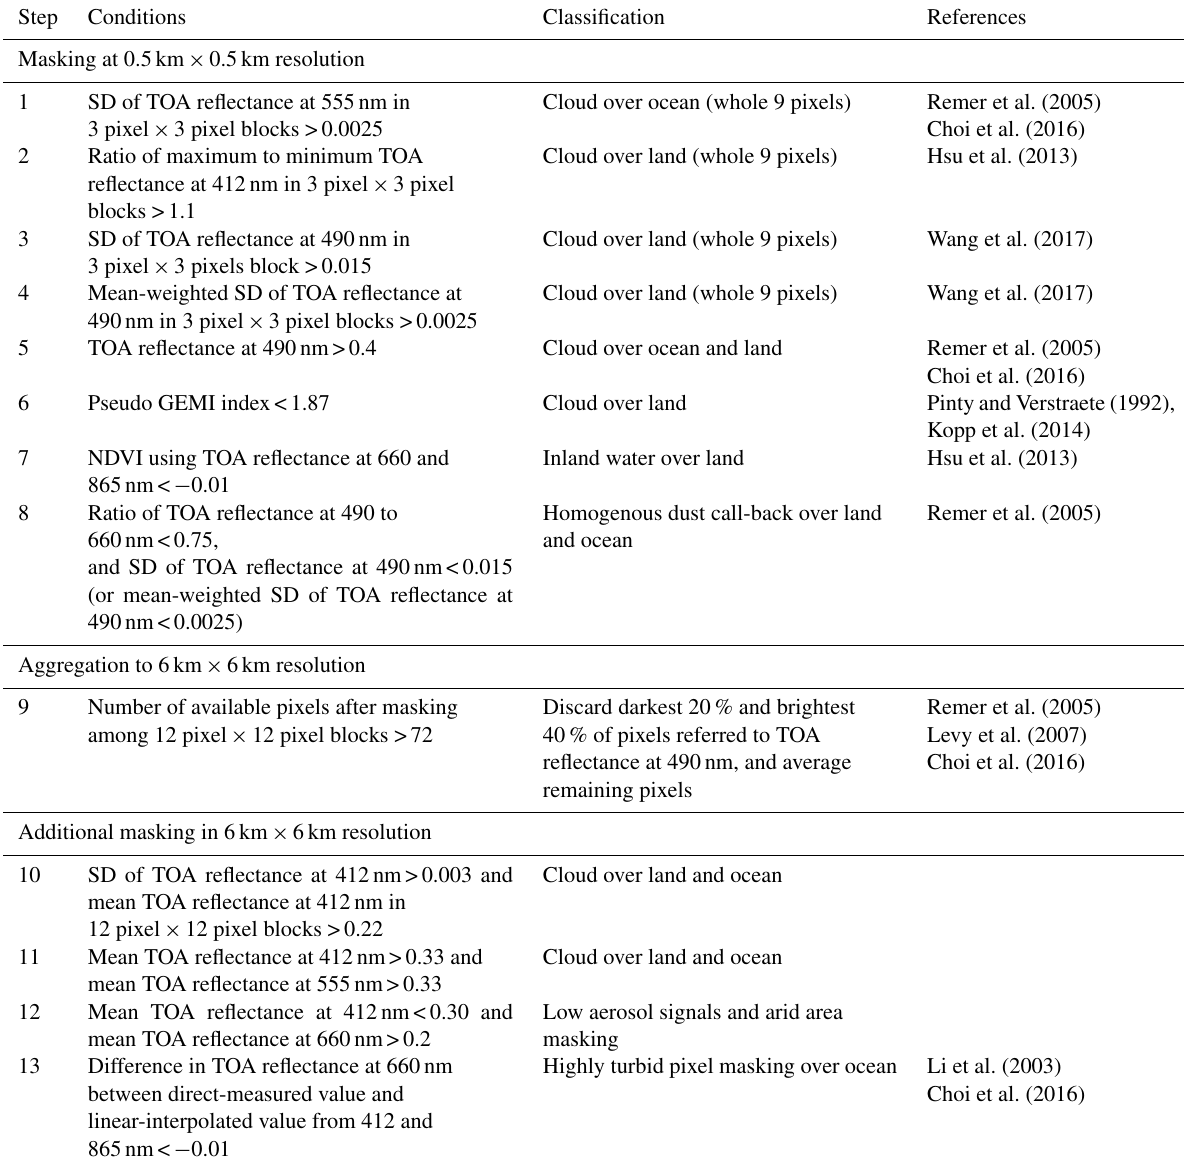
Table 1. Cloud and other pixel masking steps of the GOCI YAER V2